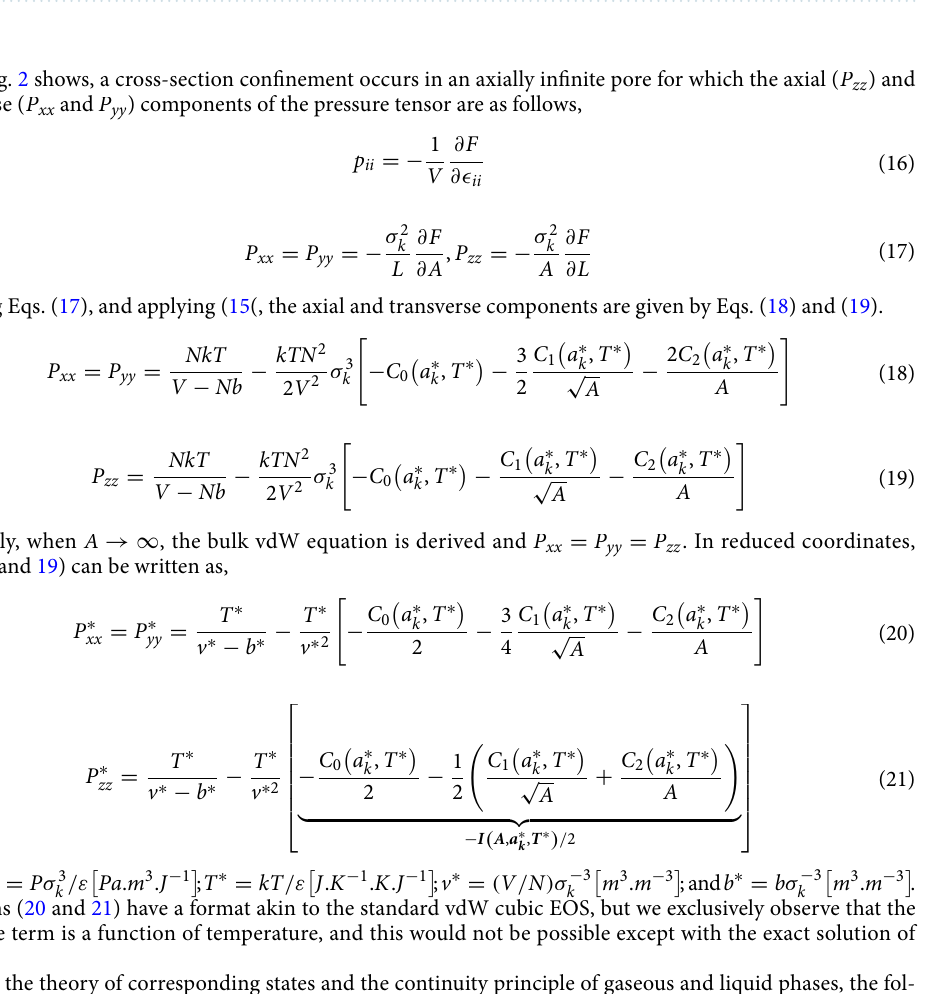
Table 1. Values of constants γ and (cid:31) for m and n